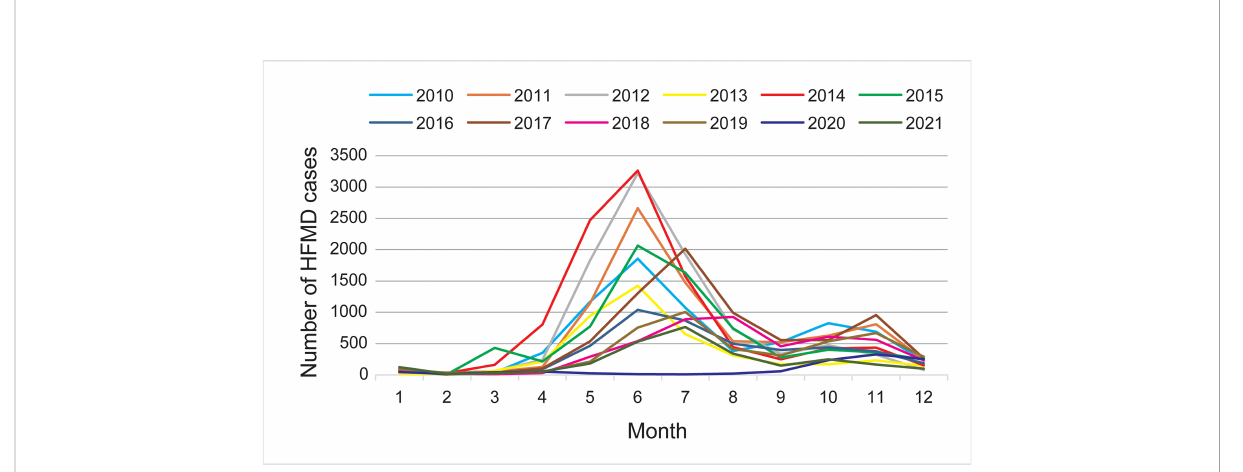
FIGURE 1 Monthly distribution of hand, foot, and mouth disease (HFMD) cases during 2010 – 2021 in